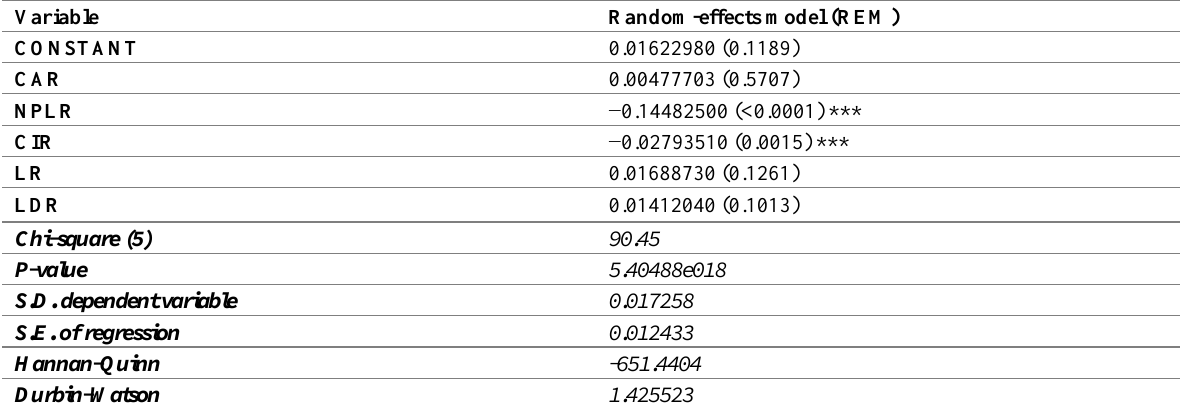
Table 8: Summary of Regression Result using the Random-effects